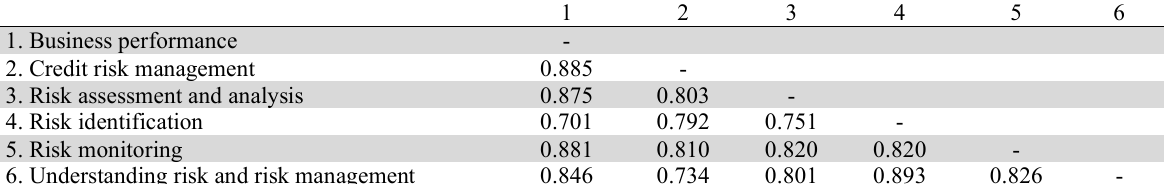
Heterotrait-Monotrait Ratio